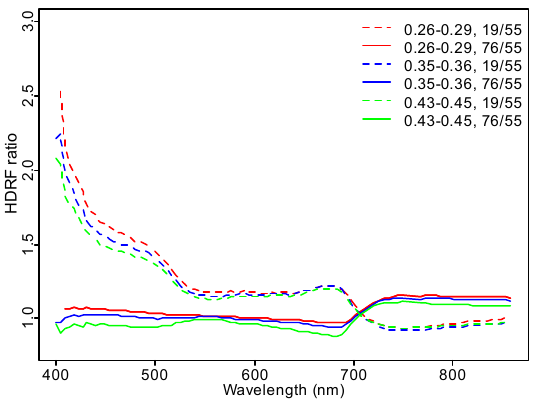
Figure 8. Ratio of Scots pine TOC spectral reflectance between sunlit fractions for three scatter angles ( β = 19°, 55°, and 76°).